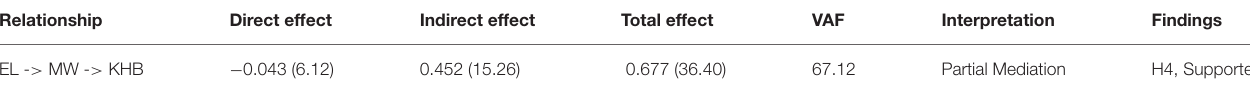
TABLE 7 | Mediation effect.